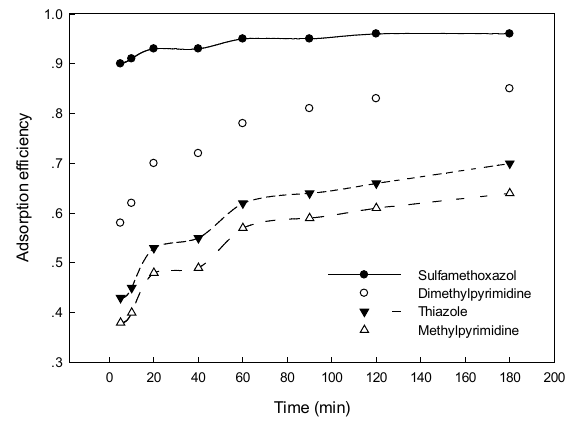
Figure 6: Adsorption kinetics of different antibiotics.